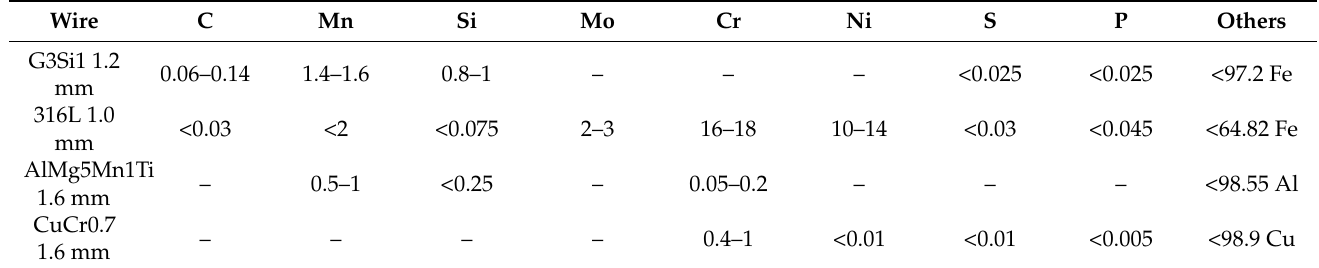
Table 1. Chemical composition of filler wires, wt.%.